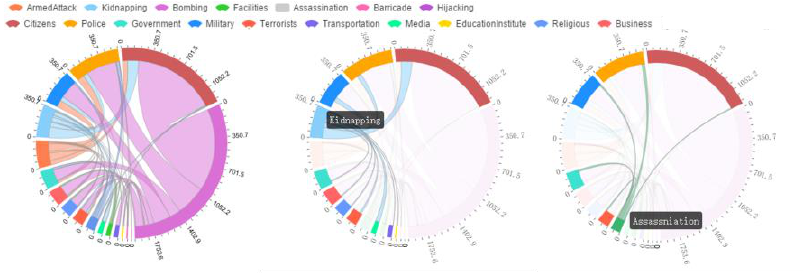
Figure 13 Relationships between event types and target